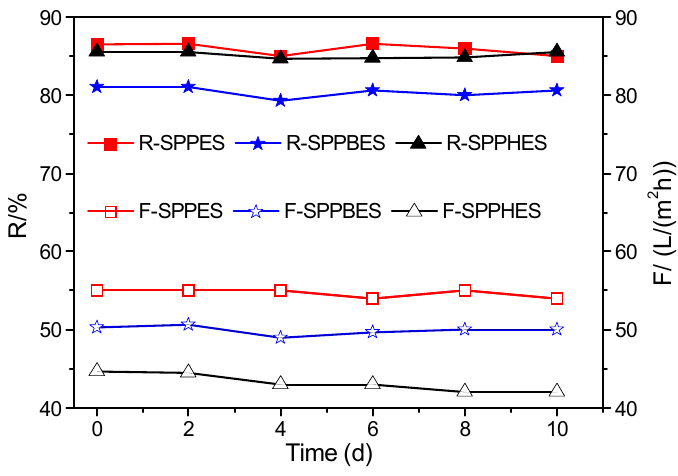
Figure 5. Chlorine resistance of composite membrane.